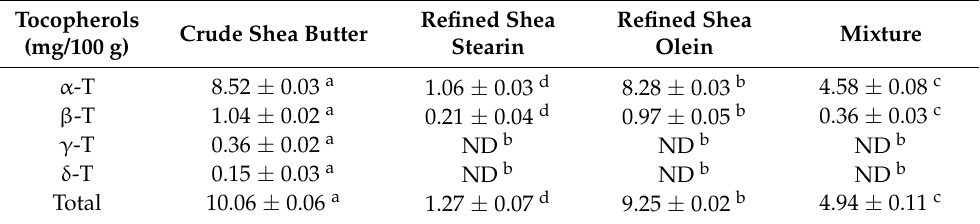
Table 4. Tocopherol content (mg/100 g) of crude shea butter, refined shea stearin, refined shea olein and a mixture of olein:stearin (1:1 w / w